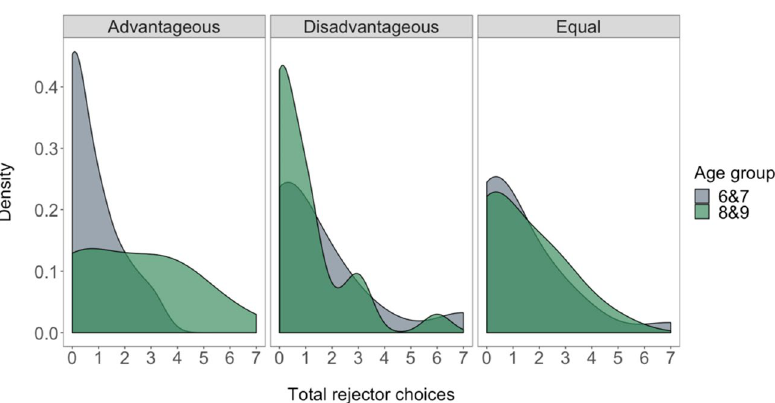
Figure 4. Distribution of children’s total rejector choices across advantageous, disadvantageous and equal conditions, by age